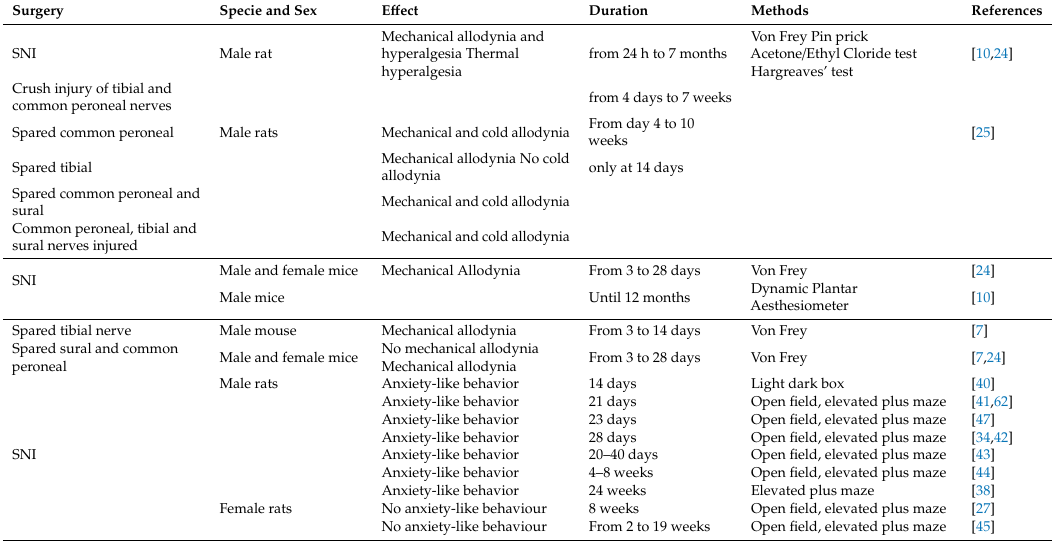
Table 1. Behavioral e ff ects of SNI